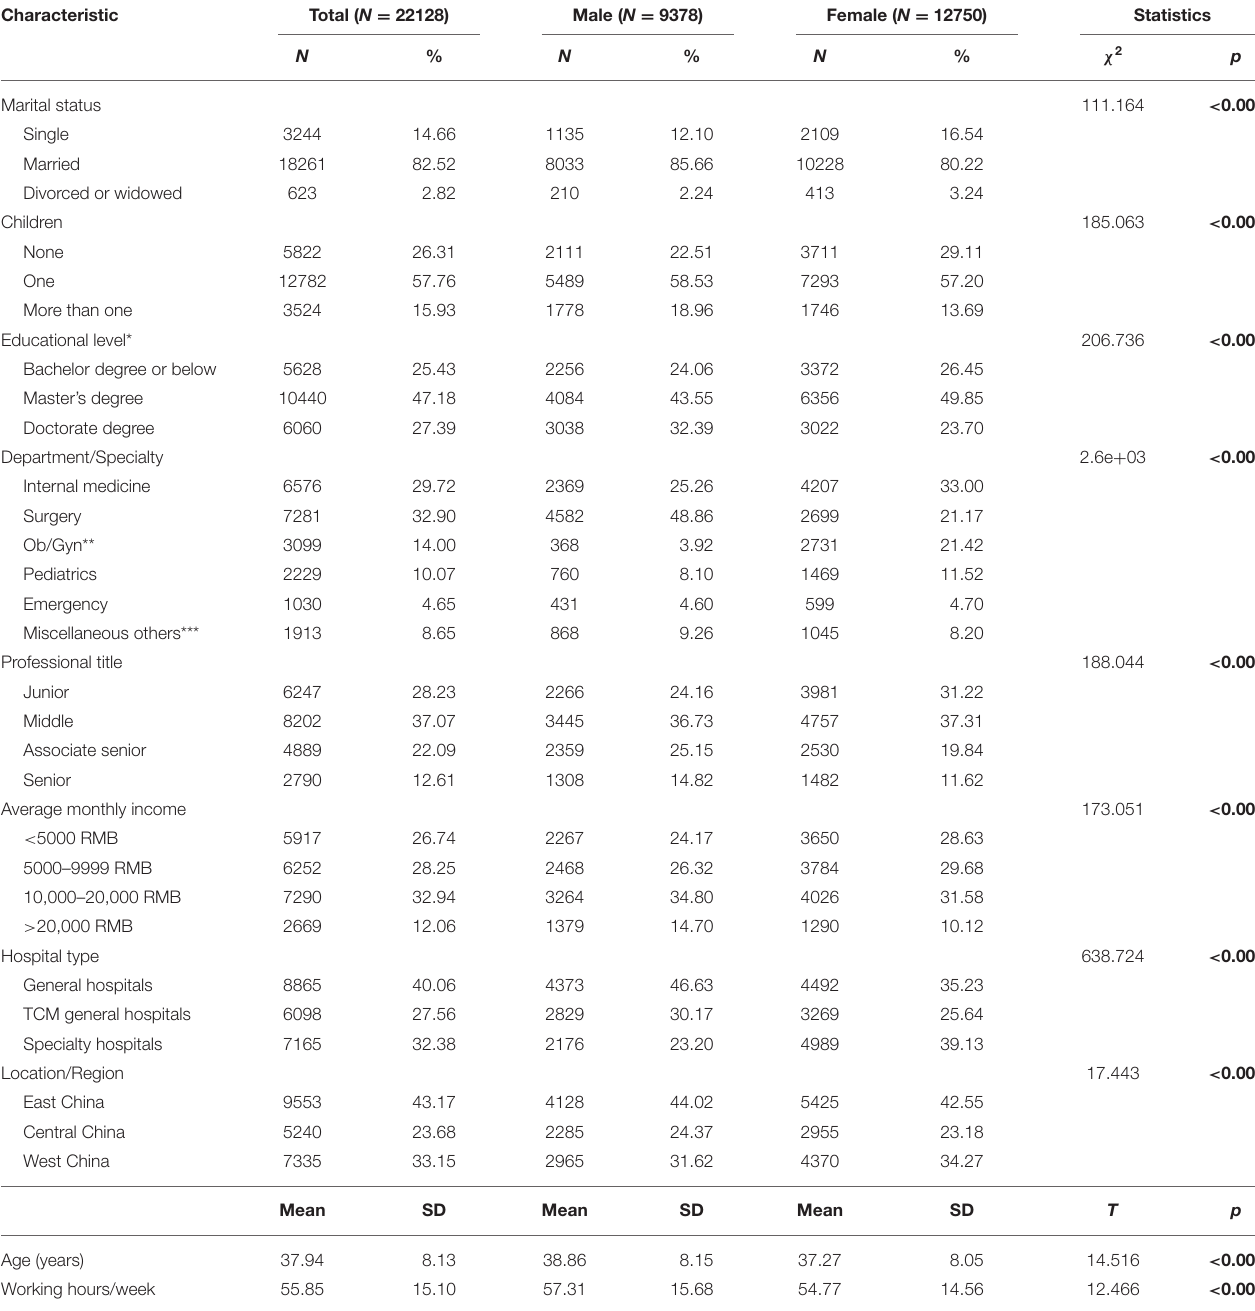
TABLE 1 | Characteristics of physicians in tertiary public